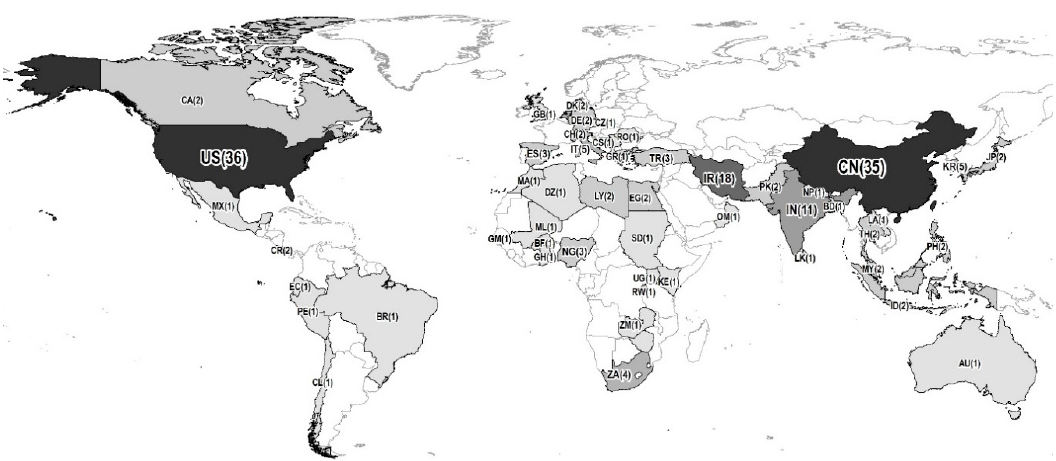
Figure 2. LCM locations for the 50 countries in the 159 reviewed articles*. (*2 duplicated prediction and 7 global prediction articles are excluded in the count; multi-national studies are counted by each country separately.)